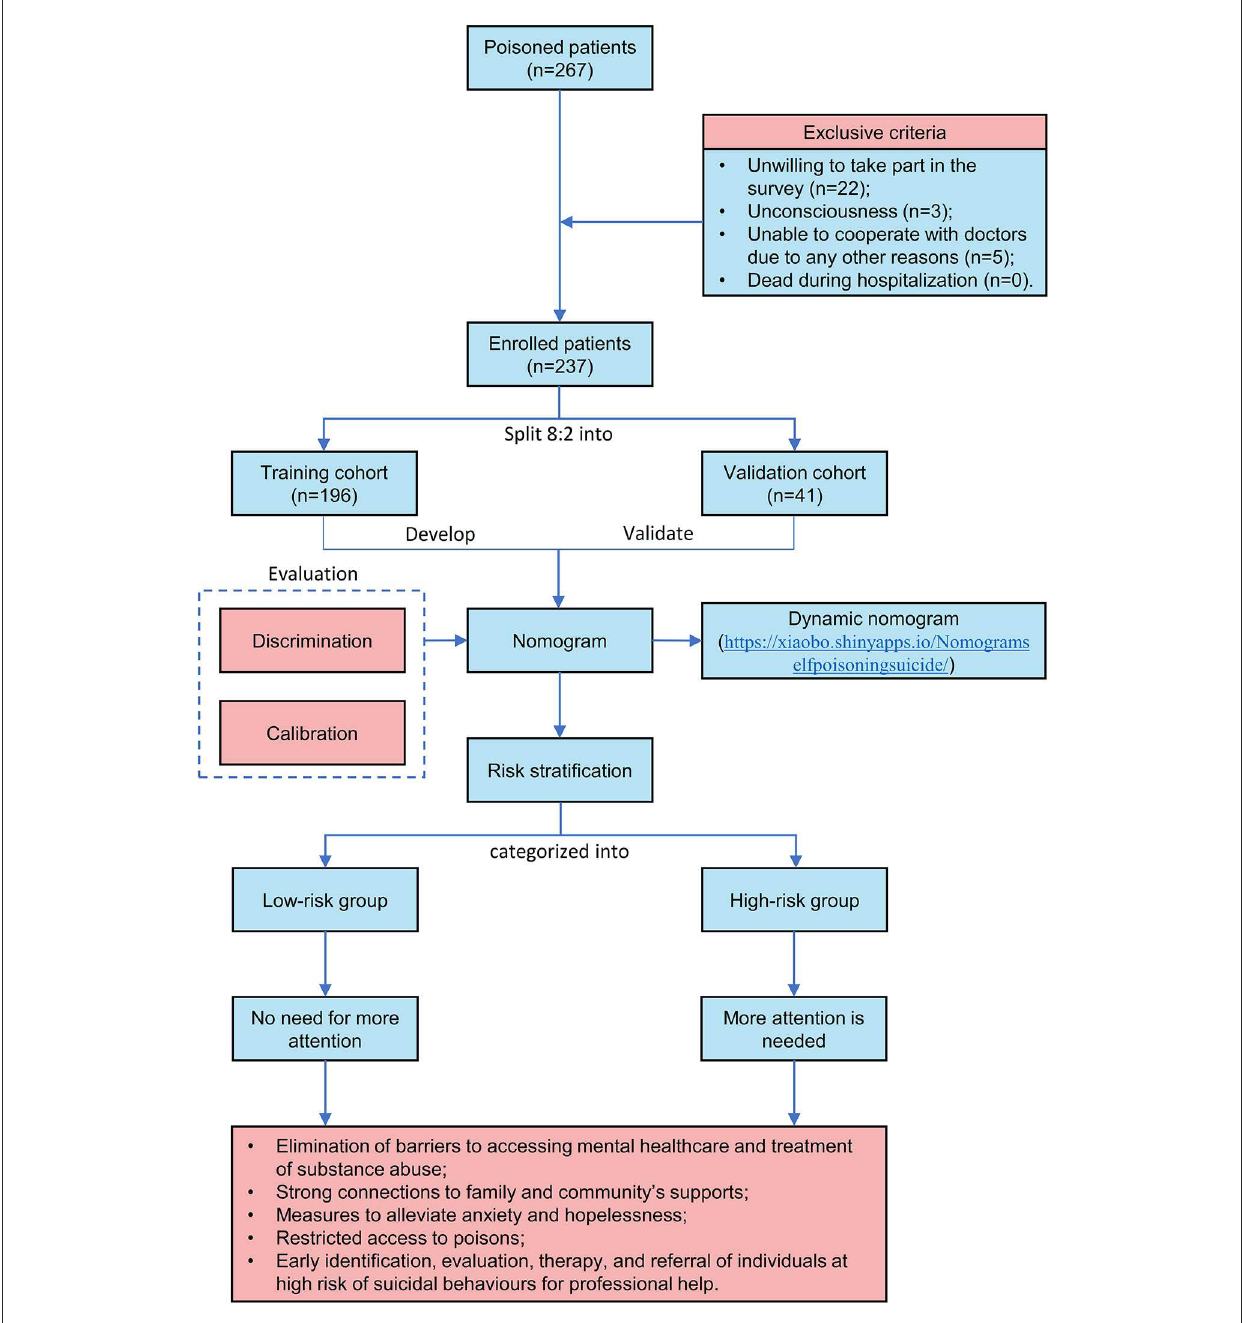
FIGURE1 Patient’s flowchart and creation of a nomogram.